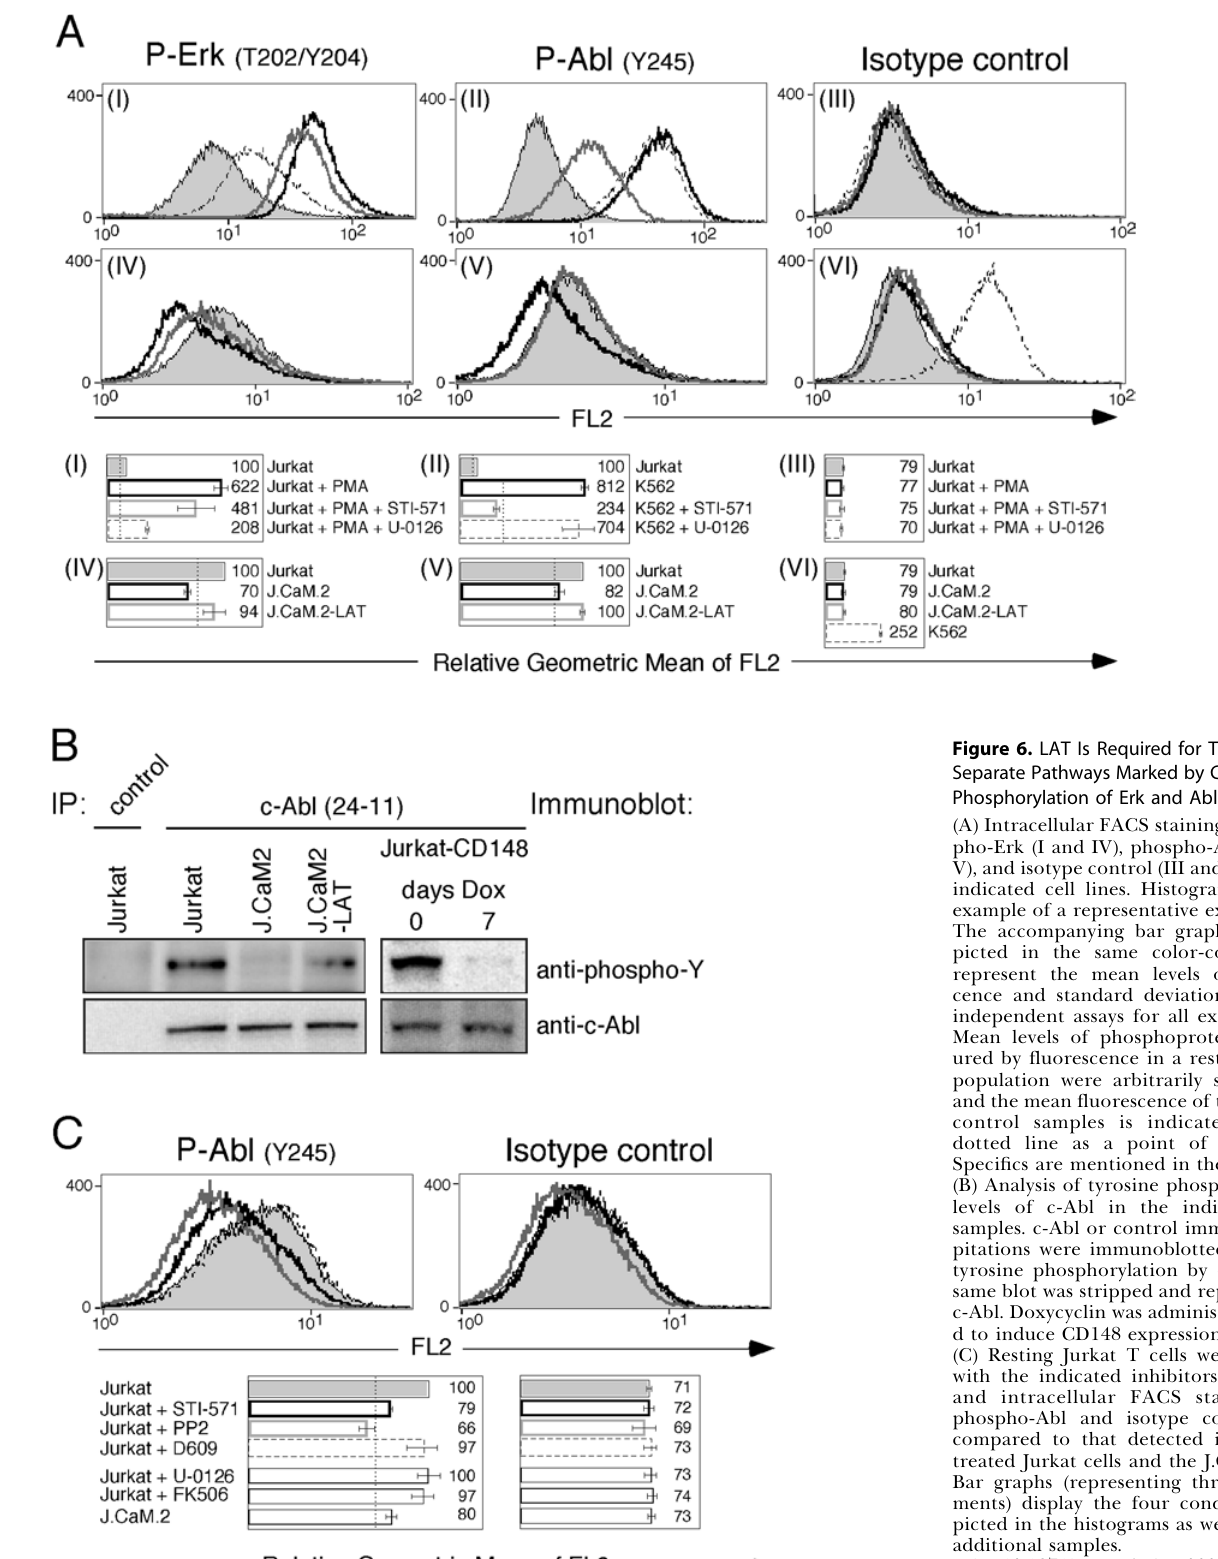
Figure 6. LAT Is Required for Two Largely Separate Pathways Marked by Constitutive Phosphorylation of Erk and Abl Kinases (A) Intracellular FACS staining for phos- pho-Erk (I and IV), phospho-Abl (II and V), and isotype control (III and VI) in the indicated cell lines. Histograms are an example of a representative experiment. The accompanying bar graphs are de- picted in the same color-coding and represent the mean levels of fluores- cence and standard deviation of three independent assays for all experiments.